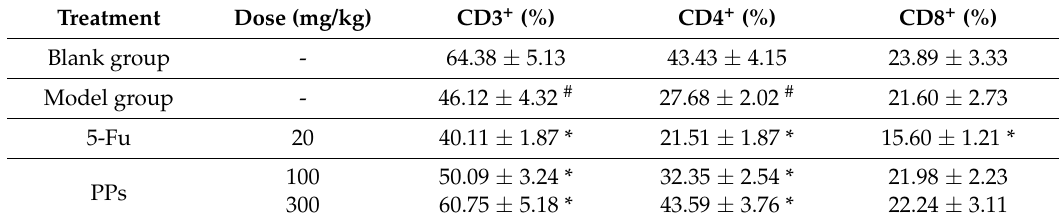
Table 3. Effects of PPs on the percentages of T lymphocyte subsets in peripheral blood of tumor-bearing mice. Treatment Dose (mg/kg) CD3 + (%) CD4 + (%) CD8 + (%) Blank group